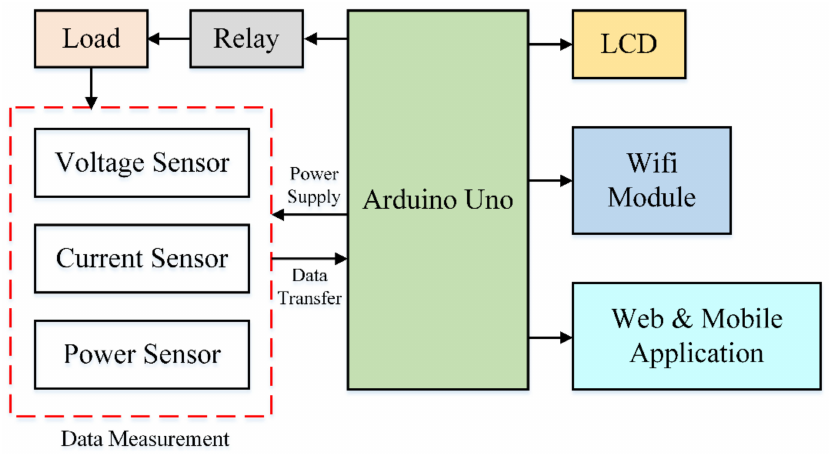
Figure 4. Block diagram of the developed ISHDB